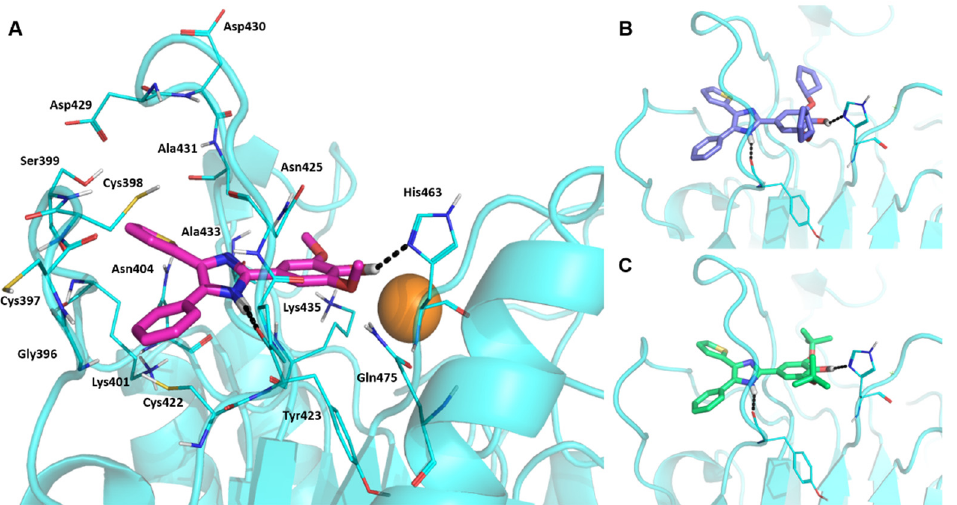
Figure 4. Molecular docking of DPTIP to nSMase2. ( A ) Putative binding mode of DPTIP (magenta sticks) in nSMase2 (shown in cyan) from the docking studies. Selected residues from the binding pocket are shown as cyan lines and labelled. Hydrogen bonds interactions with Tyr423 and His463 are shown as black dashed lines. Docking poses for active DPTIP derivatives 10 ( B ) and 11 ( C ).